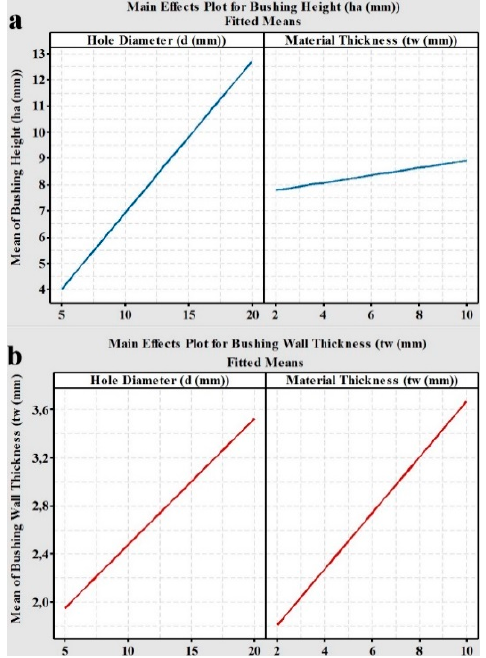
Figure 8. The effects of hole diameter and material thickness on the mean of ( a ) the bushing height, ( b ) bushing wall thickness.